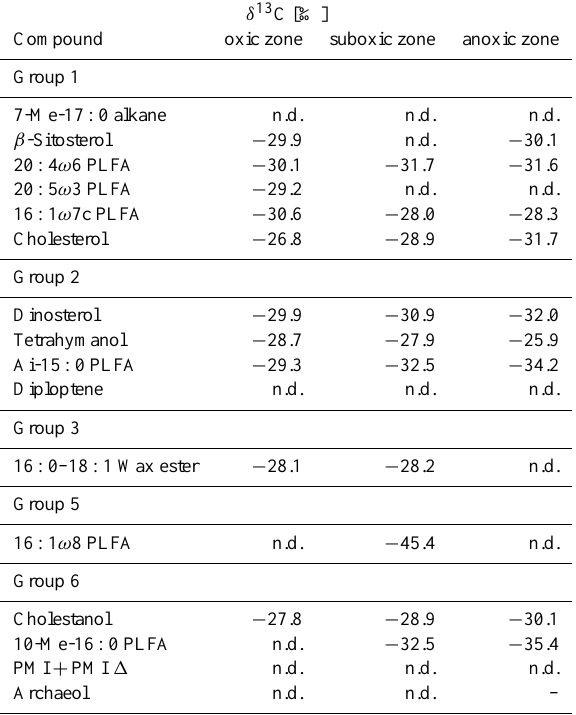
Table 1. δ 13 C values of the compounds chosen from the PCA groups. No δ 13 C values were available for Group 4. N.d. stands for “not